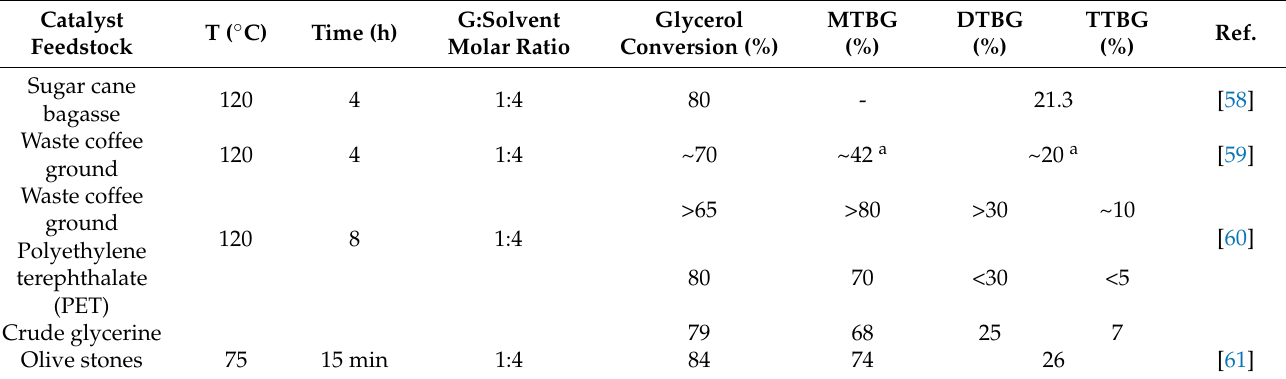
Table 4. Selectivity toward MTBG, DTBG, and TTBG of all above described catalysts according to the optimal reaction